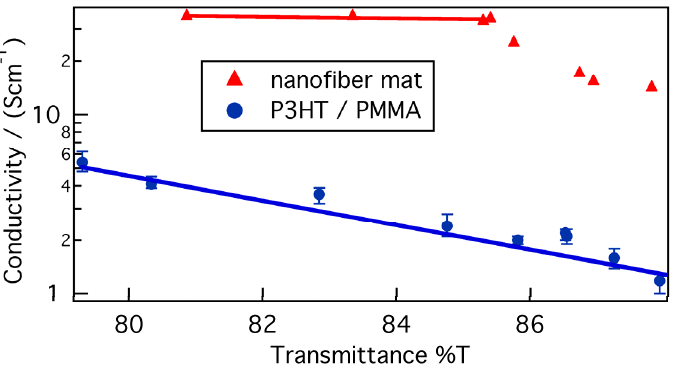
Figure 8. The conductivity of P3HT/PMMA nanofiber composite films and nanofiber mats doped by AuCl as a function of 3